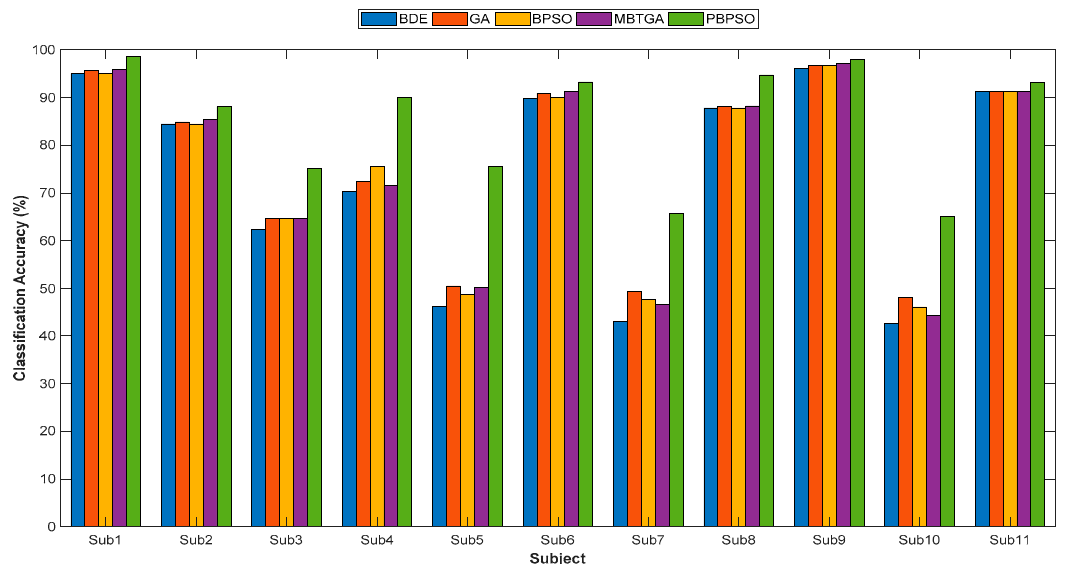
Figure 6. Classification accuracy of five different feature selection methods for 11 amputee subjects. Table 1. Results of feature size and feature reduction rate (FR) of five different feature selection methods for 11